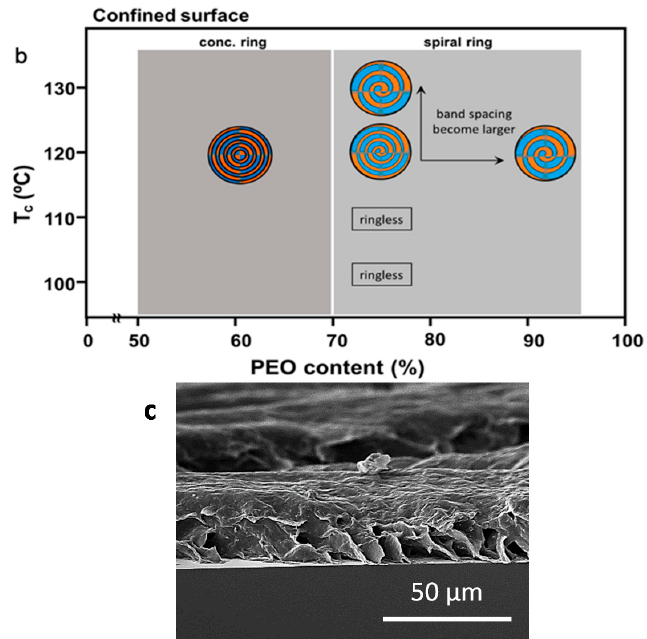
Figure 4. Schemes of PLLA spherulites in crystallized PEO/PLLA blend film samples with ( a ) free top surface and ( b ) top confined films, of different compositions and crystallized at a range of temperatures (100–130 °C); and ( c ) SEM graph of PEO/PLLA (83/17) blend without top-cover confinement, crystallized successively at T c = 120 °C, then cooled to room temperature. Interior lamellae showing orientation-induced cracks and interfaces. Reproduced with permission from Ref. [11].